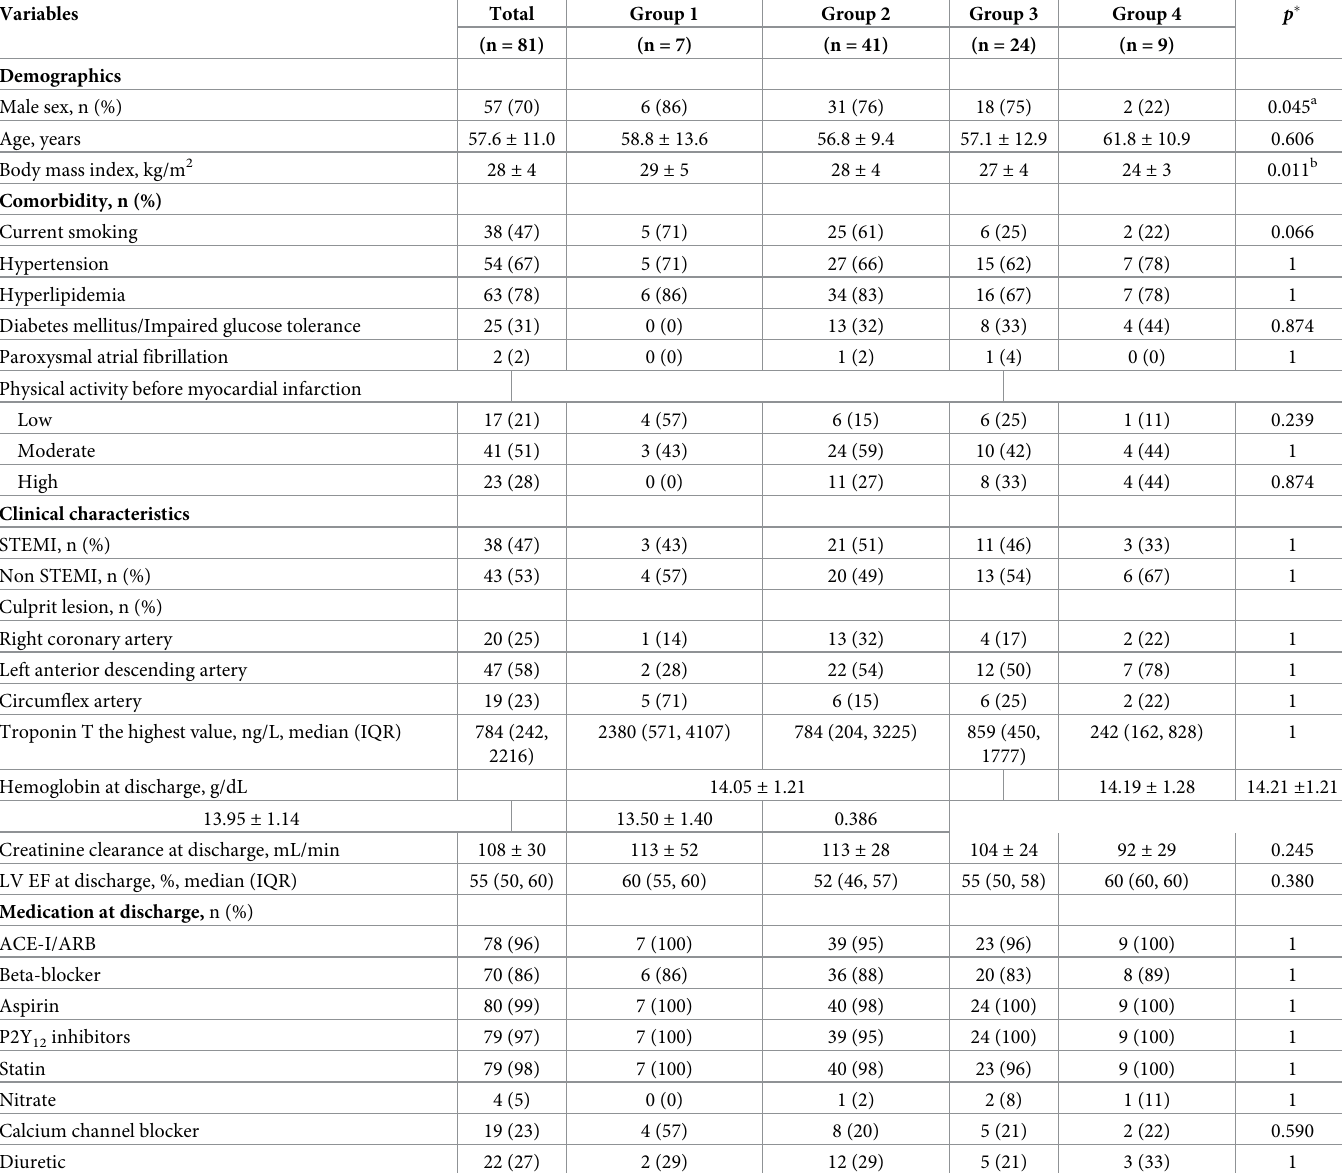
Table 1. Demographic and clinical characteristics during hospitalization for acute myocardial infarction according to percentage of predicted oxygen uptake (Group 1, < 50%; Group 2, 50–74%; Group 3, 75–99%; and Group 4, �